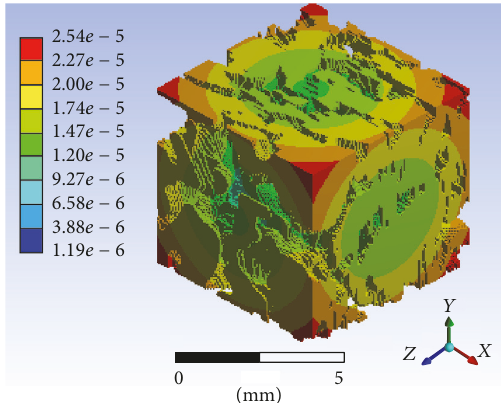
Figure 6: Thermal strain distribution of model MS1 under the temperature of 100 ∘ C.